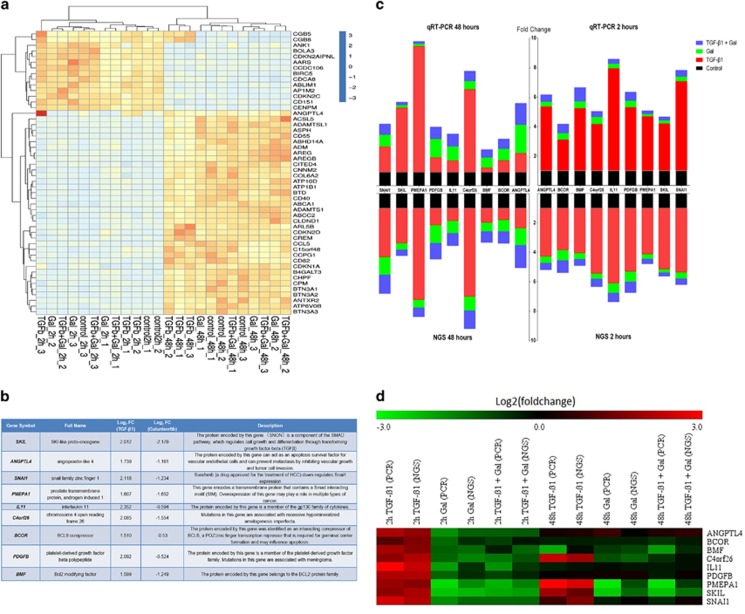
NGS data in HLF cell line from MACE and validation by qRT-PCR. Three replicates were performed for each condition. (a) Clustered heat map of normalized sequence counts of the genes with the highest expression as determined by MACE. (b) Transcriptional response of selected potential biomarkers to both TGF-β1 and galunisertib (gal). (c) Comparison of mRNA expression measurement results obtained with either qRT-PCR or MACE. For each gene, the change of expression level is calculated by fold change. (d) Expression of mRNA of target genes in comparison with their expression levels in control samples as measured by qRT-PCR. For each gene, the change of expression (−ΔΔCt) is calculated by – (delta Ct target–delta Ct control) and for MACE data the log2 fold change is used)